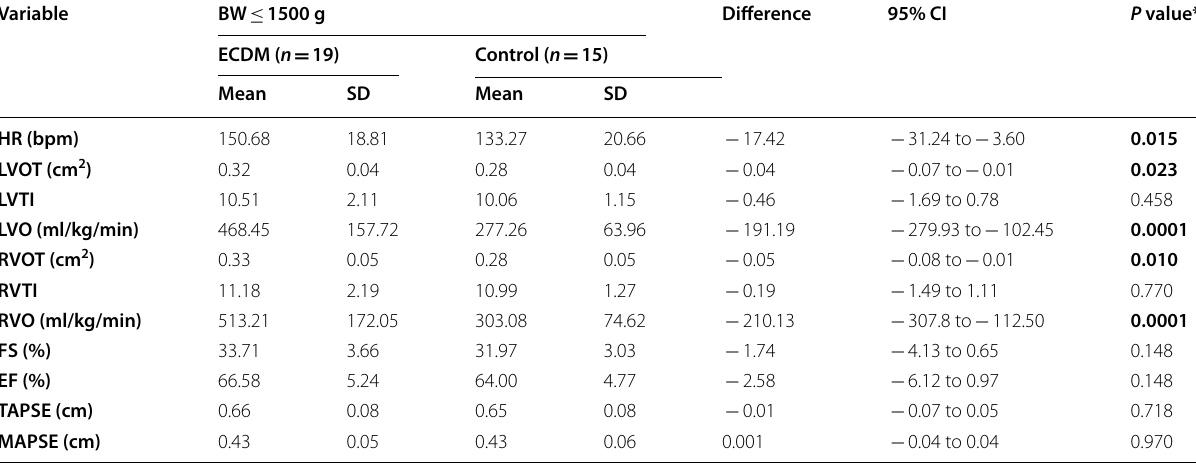
Table 4 Comparison of the echocardiography‑directed management (ECDM) group after treatment and the control group in the cohort of patients with birth weight 1500 ≤